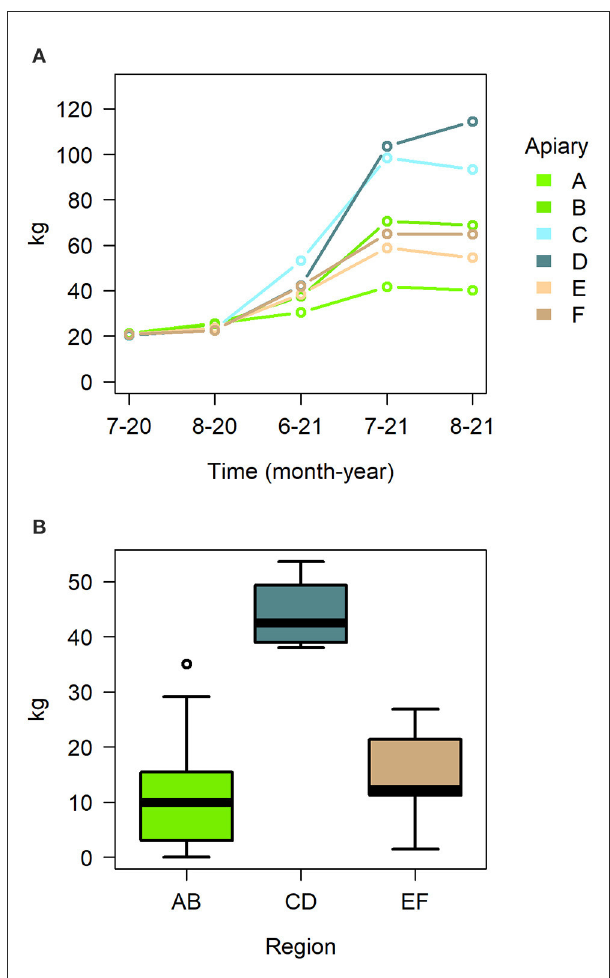
FIGURE4 (A) Median hive weight in apiaries during the season 2021, (B) honey yield in the different regions as boxplot with mean and